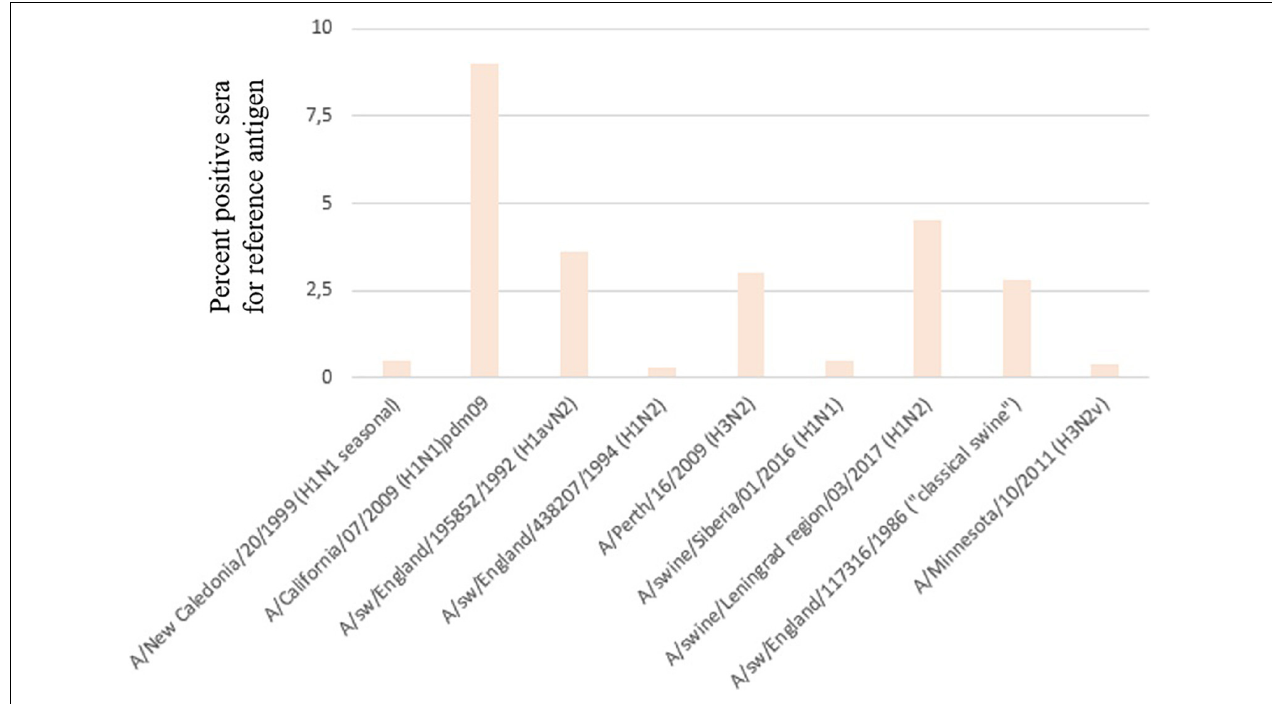
FIGURE 6 | Percentage of serum samples that tested positive for reference antigens.